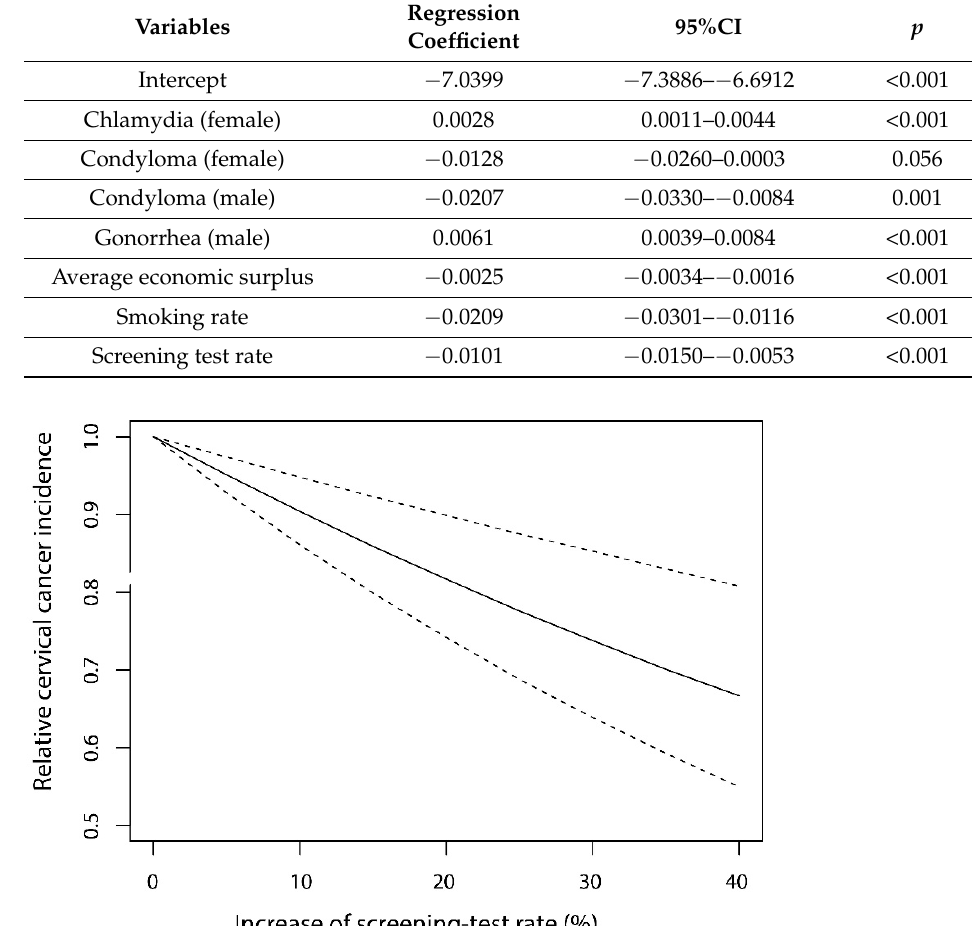
Figure 3 . The prediction of decrease in the relative cervical cancer incidence by the increase of screening test rate.